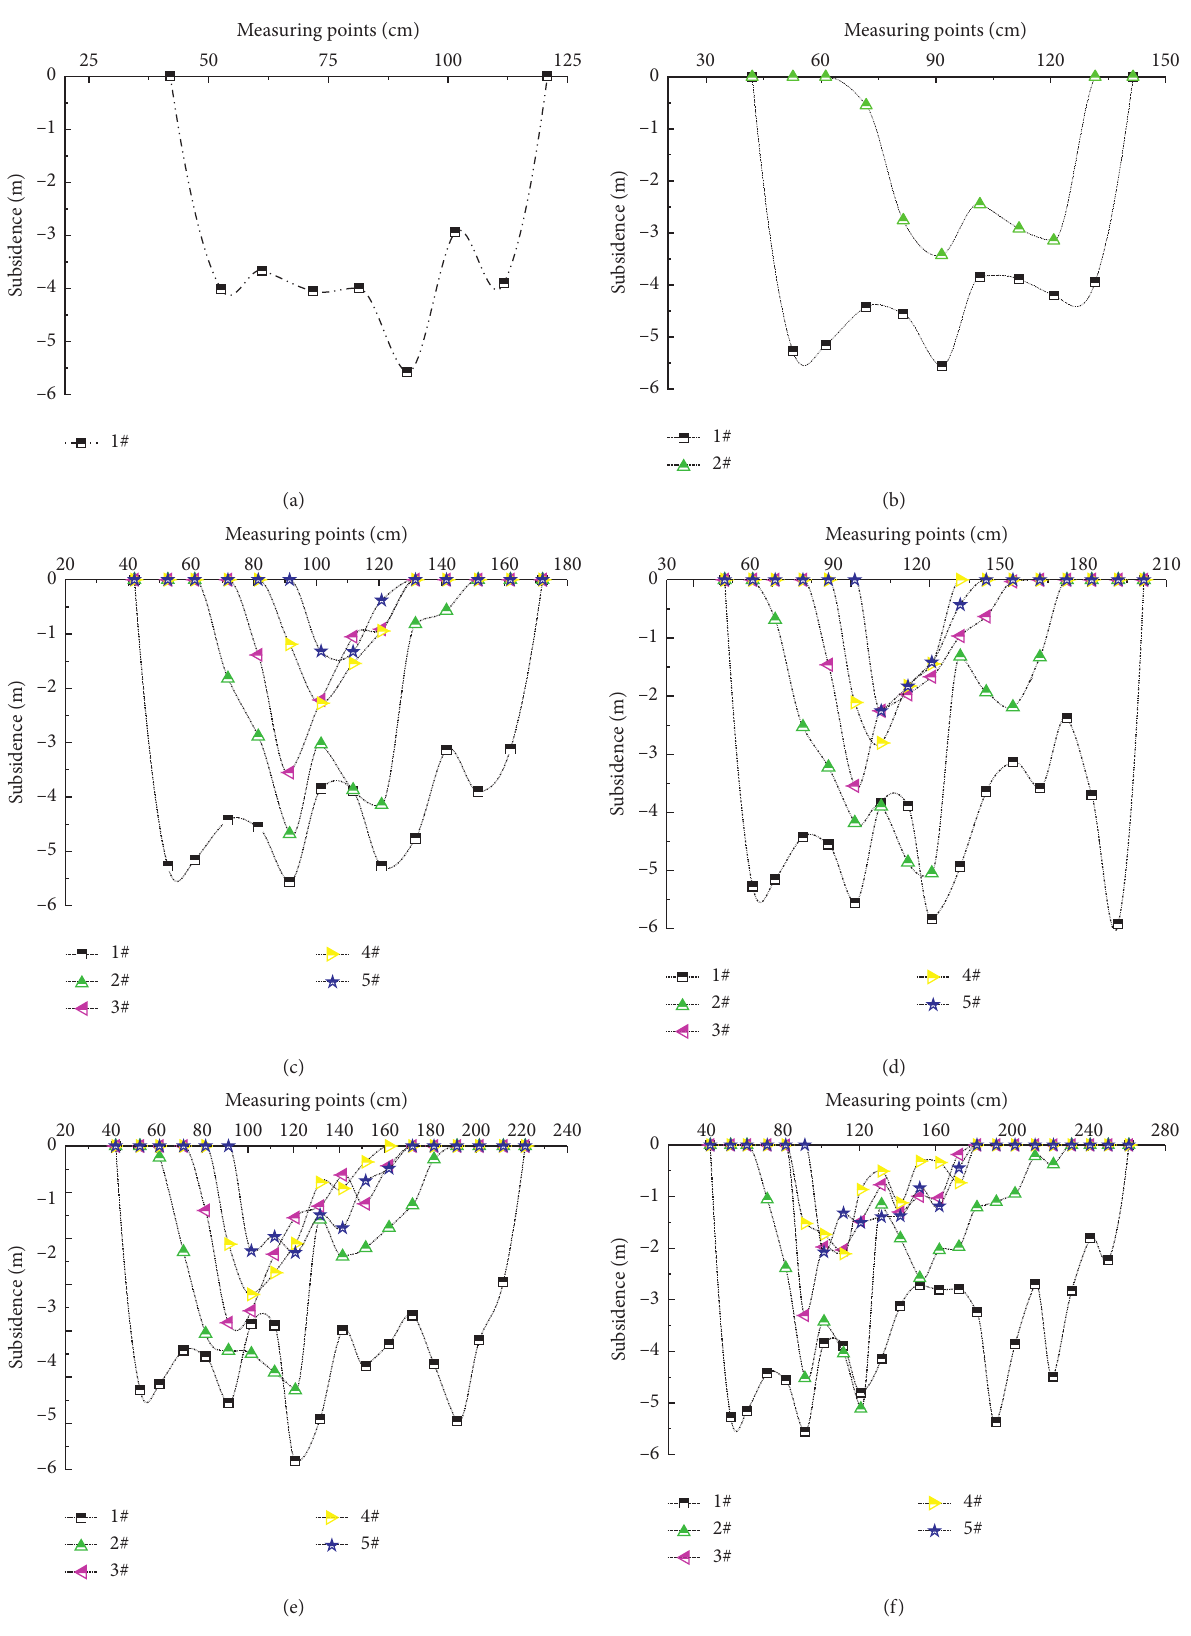
Figure 7: Overlying stratum subsidence in similar simulations: (a) extraction of the 4-2# coal seam at 85m; (b) extraction of the 4-2# coal seam at 100m; (c) extraction of the 4-2# coal seam at 130m; (d) extraction of the 4-2# coal seam at 160m; (e) extraction of the 4-2# coal seam at 190m; (f) completed extraction of the 4-2# coal